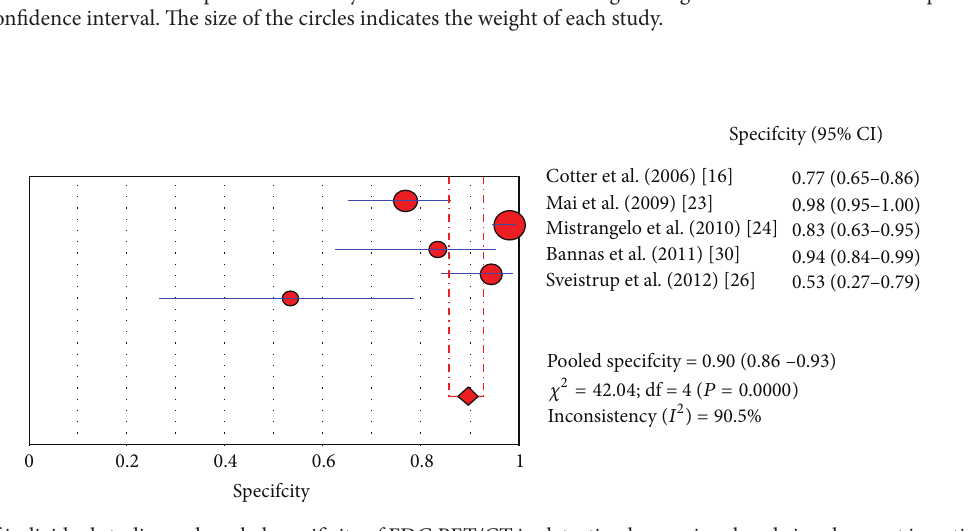
Figure 3: Plot of individual studies and pooled specificity of FDG PET/CT in detecting locoregional node involvement in patients with ACC on a per lesion-based analysis, including 95% confidence interval. The size of the circles indicates the weight of each study.